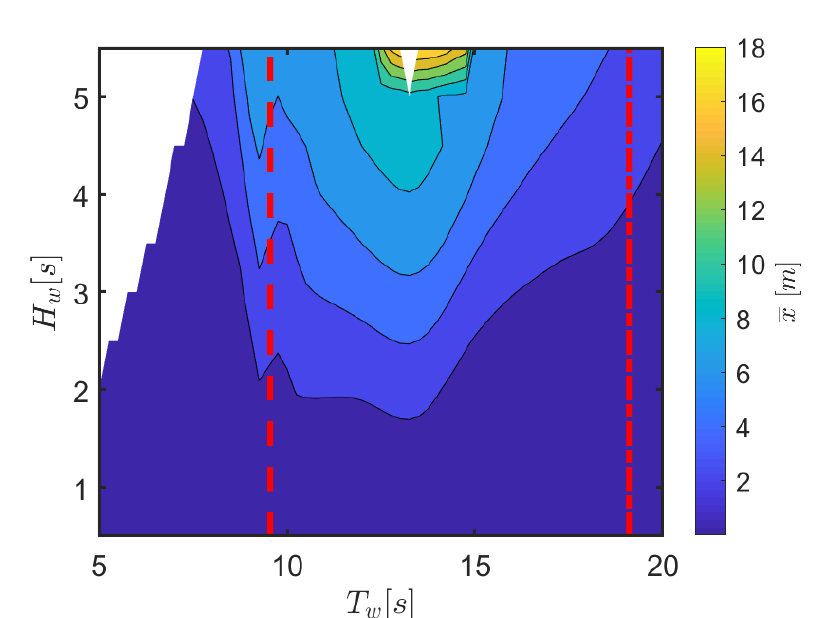
Figure 5. Mean displacement in surge x due to drift effects for configuration m 3 as a function of T w and H w . The dashed and dash-dotted red lines correspond to T w = 1